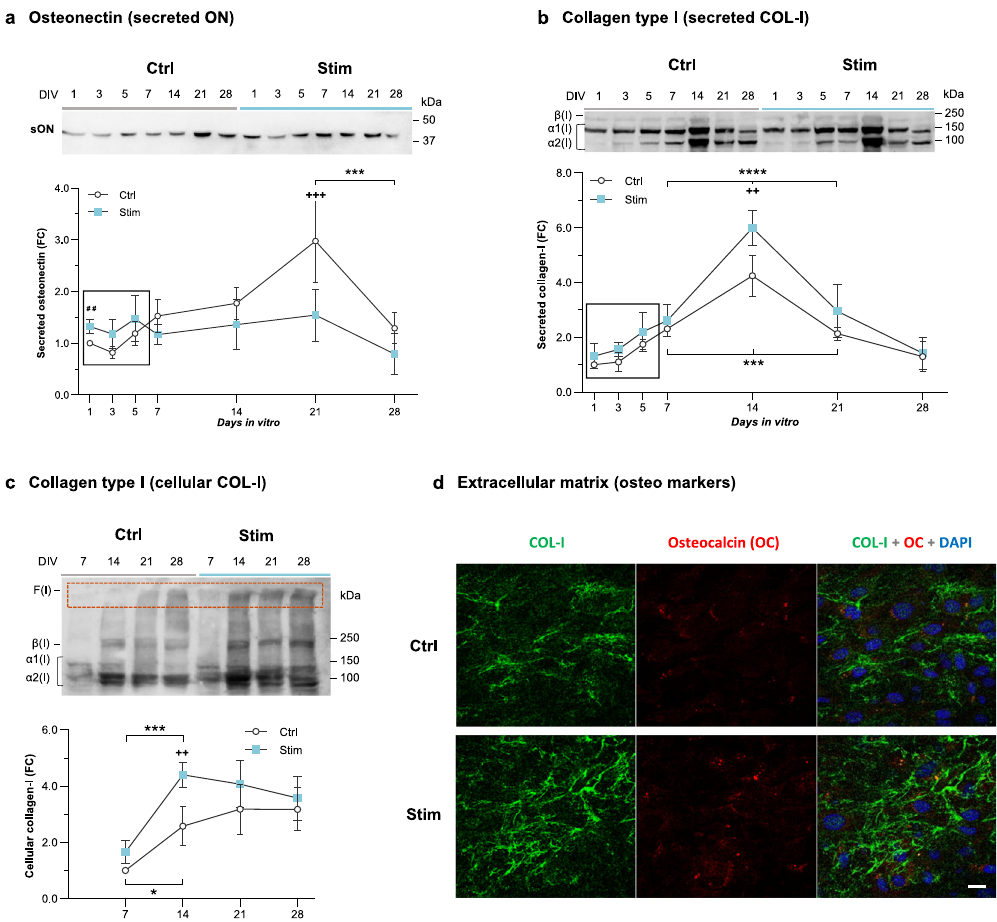
Fig. 2 Matrix maturation of MC3T3 osteoblasts under high frequency stimulation. Immunoblot analyses and relative quanti fi cation of time- dependent pro fi les of a osteonectin (secreted ON, n = 4) and b collagen-I (secreted COL-I, n = 4) secreted into cells ’ conditioned medium, and c intracellular collagen-I forms: α 1(I) and α 2(I) monomeric chains, β (I), dimeric forms and F(I), collagen fi brils (cellular COL-I; n = 4). Cellular COL- I image was fi ltered post-analysis (Image J “ remove outliers ” fi lter) for clearer presentation. Molecular weights are indicated to the right. DIV, days in vitro. Fold changes over Ctrl condition at fi rst analytical time point. d Immunostaining of collagen-I (in green) and osteocalcin (in red) distributed in the extracellular matrix upon 28 DIV under Ctrl or Stim conditions. Cells ’ nuclei were counterstained with DAPI (blue); scale bar, 20 μ m. Results are presented as mean ± SD. Statistic symbols: ( + /# ) Ctrl vs Stim conditions; (*) between timepoints within the same condition; ( + / *) two-way ANOVA; ( # ) one-way ANOVA; * P < 0.05, ++ /## P < 0.01, *** / +++ P < 0.001, **** P <